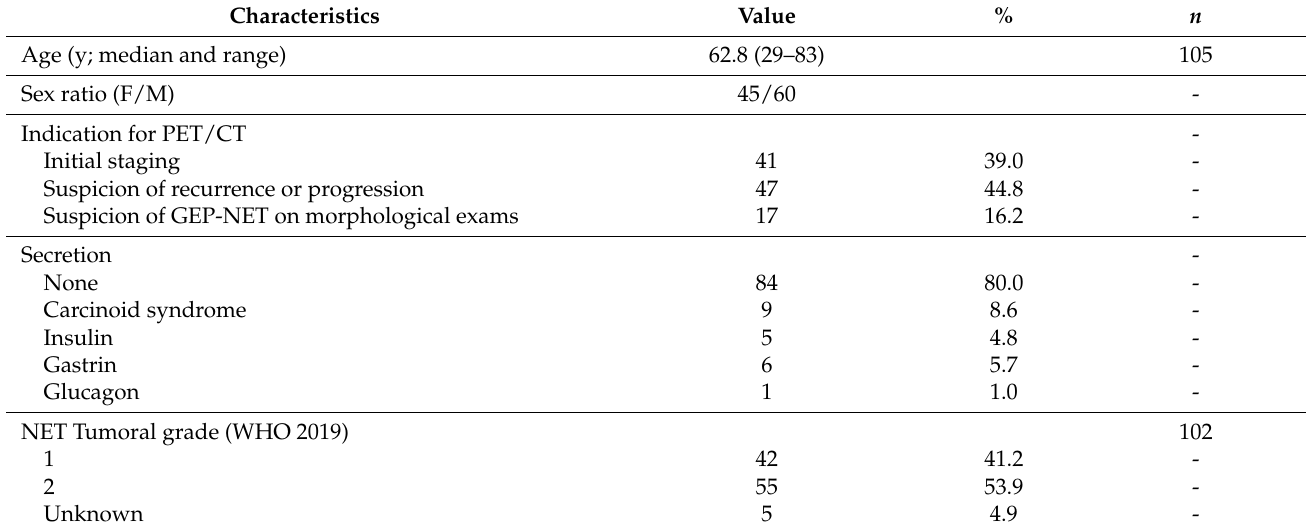
Table 1. Patients’ characteristics at